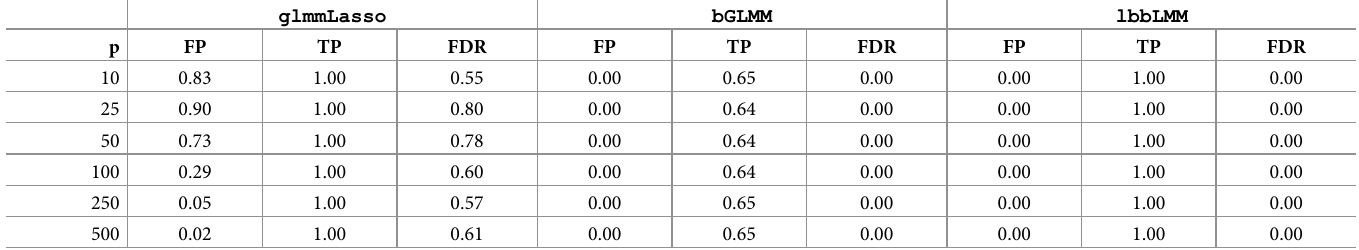
Table 3. Variable selection properties averaged over 300 runs for each p-dimensional random intercepts setup. True positives (TP), false positives (FP) and false dis- covery rate (FDR). Since no noticeable variability regarding the choice of τ occurred, results are summarized.